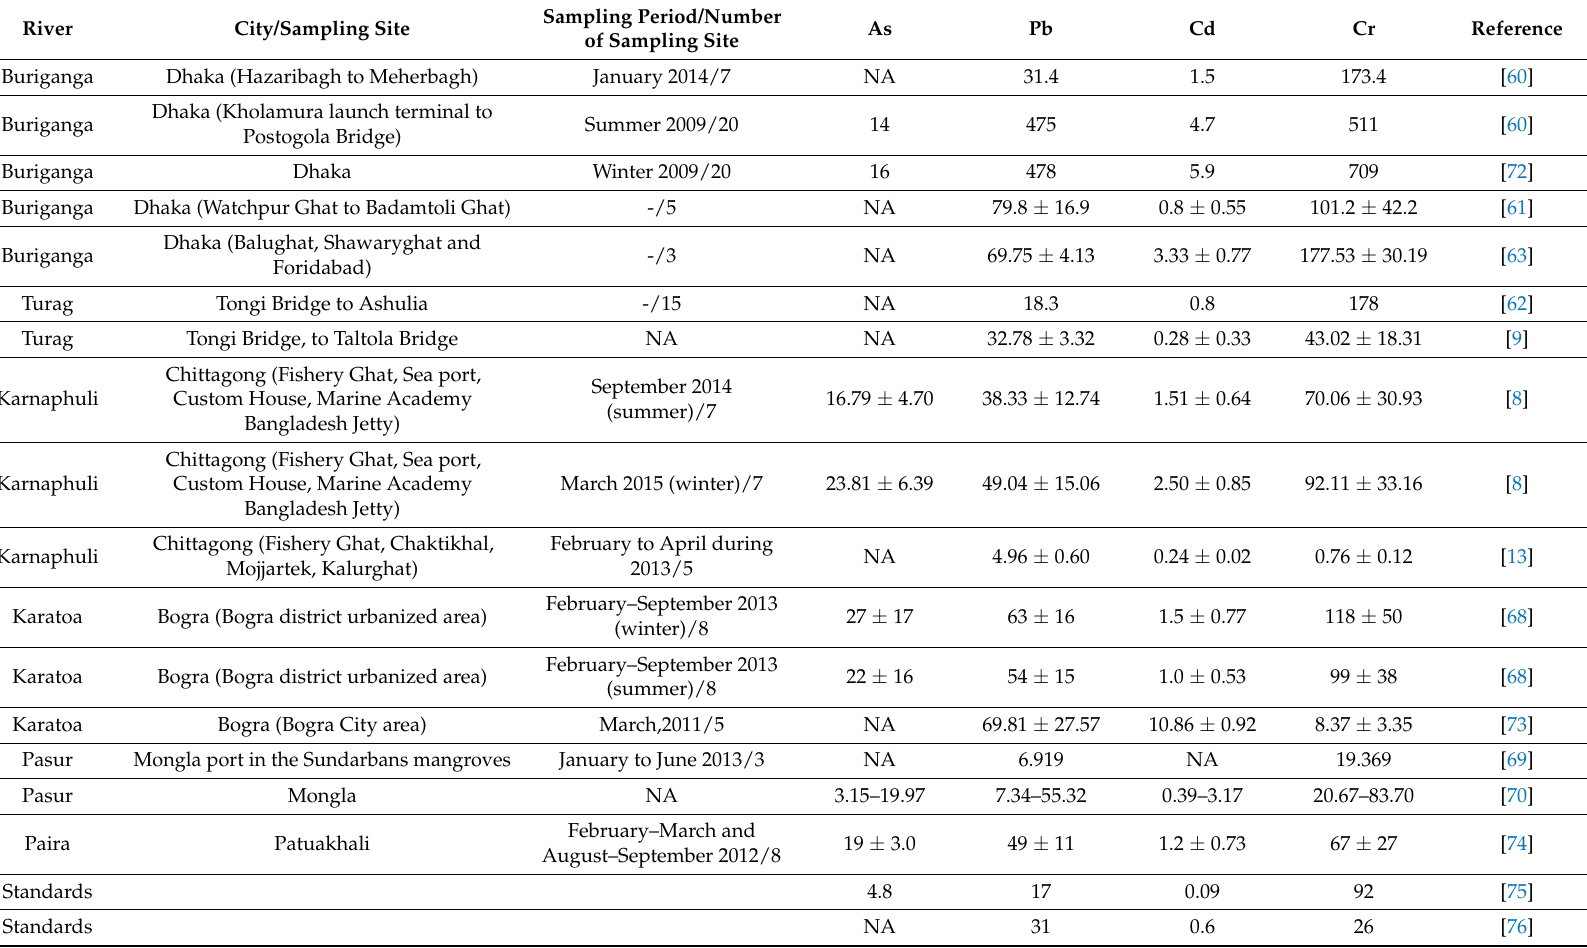
Table 3. Heavy metal and metalloid pollution in river sediments